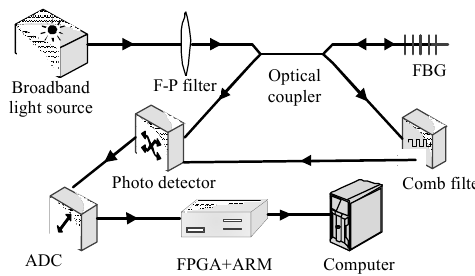
Fig. 1 Schematic diagram of FBG interrogation system.